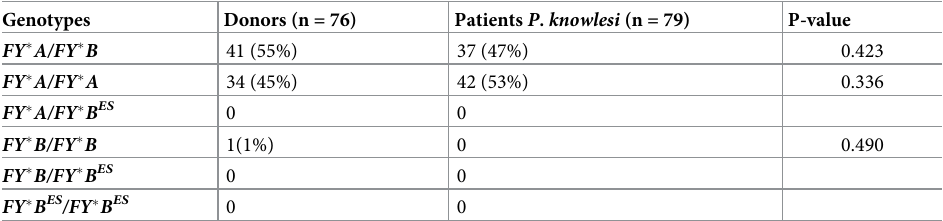
Table 1. Comparison of genotypic frequencies between blood donors and P . knowlesi infected patients.